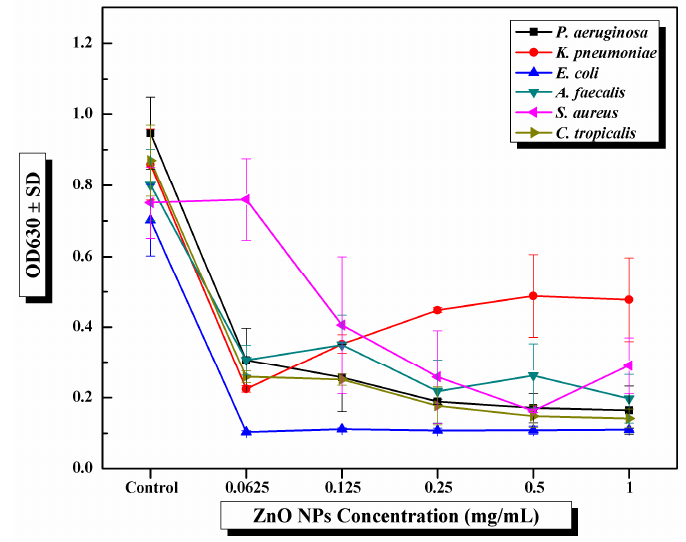
Figure 1. Effect of ZnO NPs at subMIC concentrations on the biofilm formation of the selected strong biofilm forming isolates. The biofilm formation was quantified by OD630 and compared to the optical density cutoff value (ODc). Results are displayed as the mean OD630 ± SD, which significantly decreased at ZnO NPs of 0.0625 mg/mL and at a ZnO NPs concentration of 0.125, 0.25, and 1 mg/mL using a one-way ANOVA followed by a post hoc Dunnett’s test.